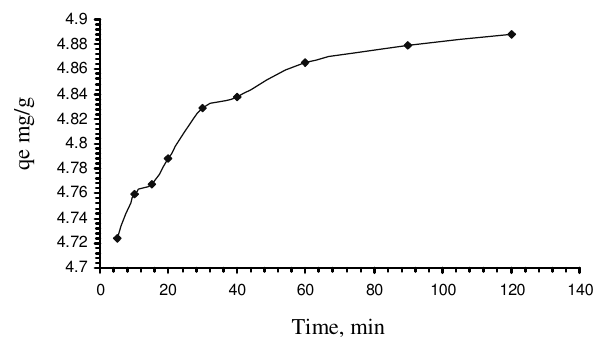
Figure 3. Effect of contact time on the adsorption of Cu(II) onto PFA .